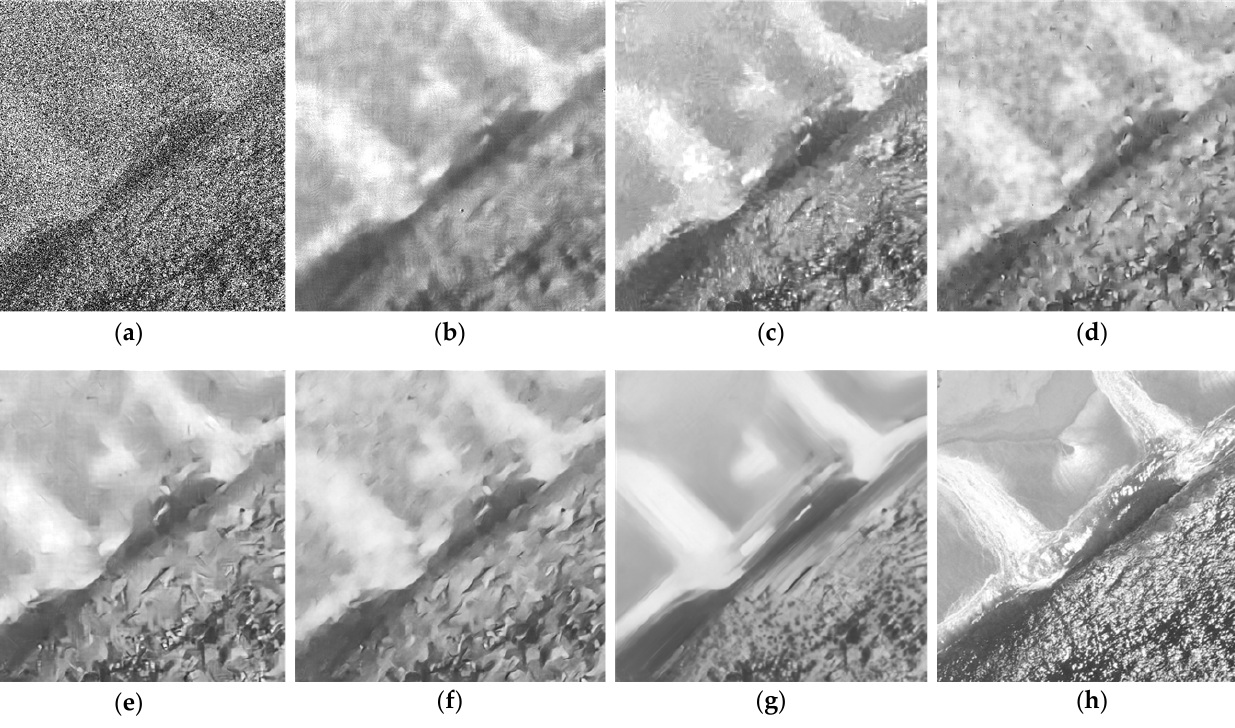
Figure 7. Despeckling results for the Beach image. ( a ) Speckled. ( b ) PPB. ( c ) SAR-BM3D. ( d ) ID-CNN. ( e )